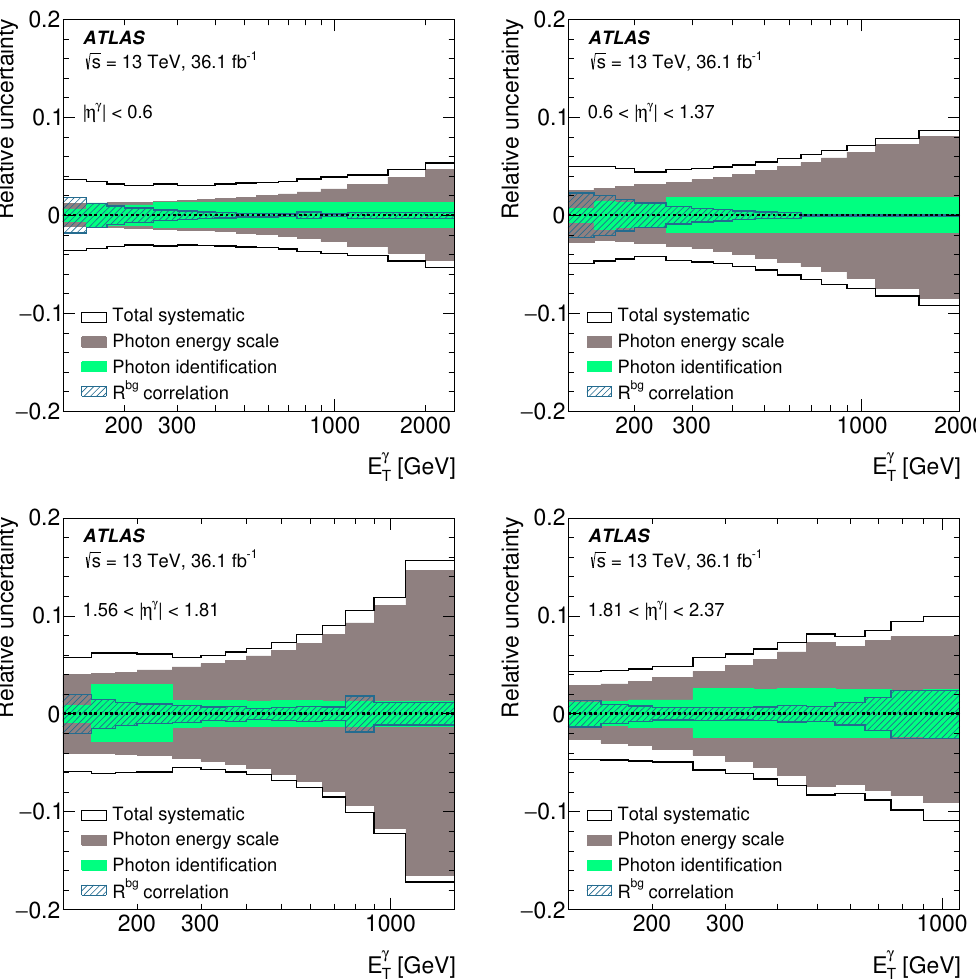
Figure 1 . The relative total systematic uncertainty in the cross section (white areas) as a function of E (cid:13) in di(cid:11)erent j (cid:17) (cid:13) j regions. The relative uncertainty due to the photon energy scale (grey areas), T the relative uncertainty due to the photon identi(cid:12)cation e(cid:14)ciency (green areas) and the relative uncertainty due to R bg (blue hatched areas) are also